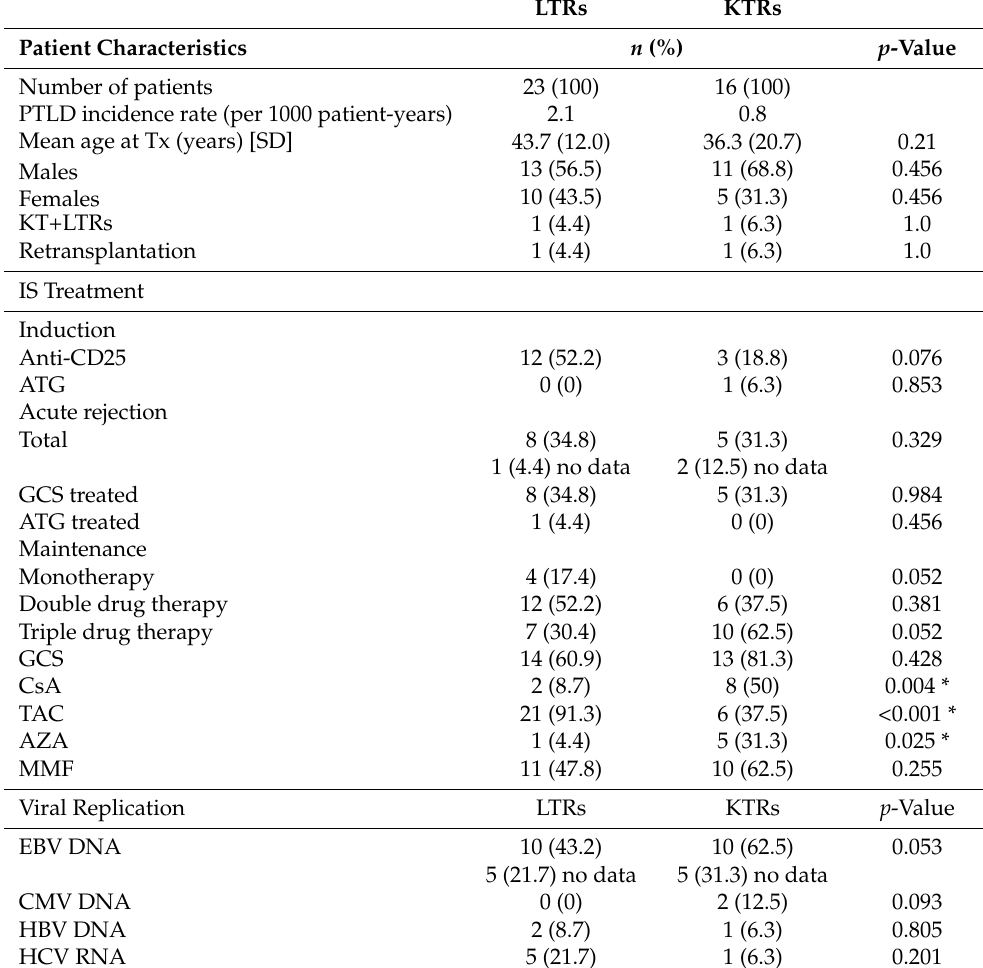
Table 1. Clinical